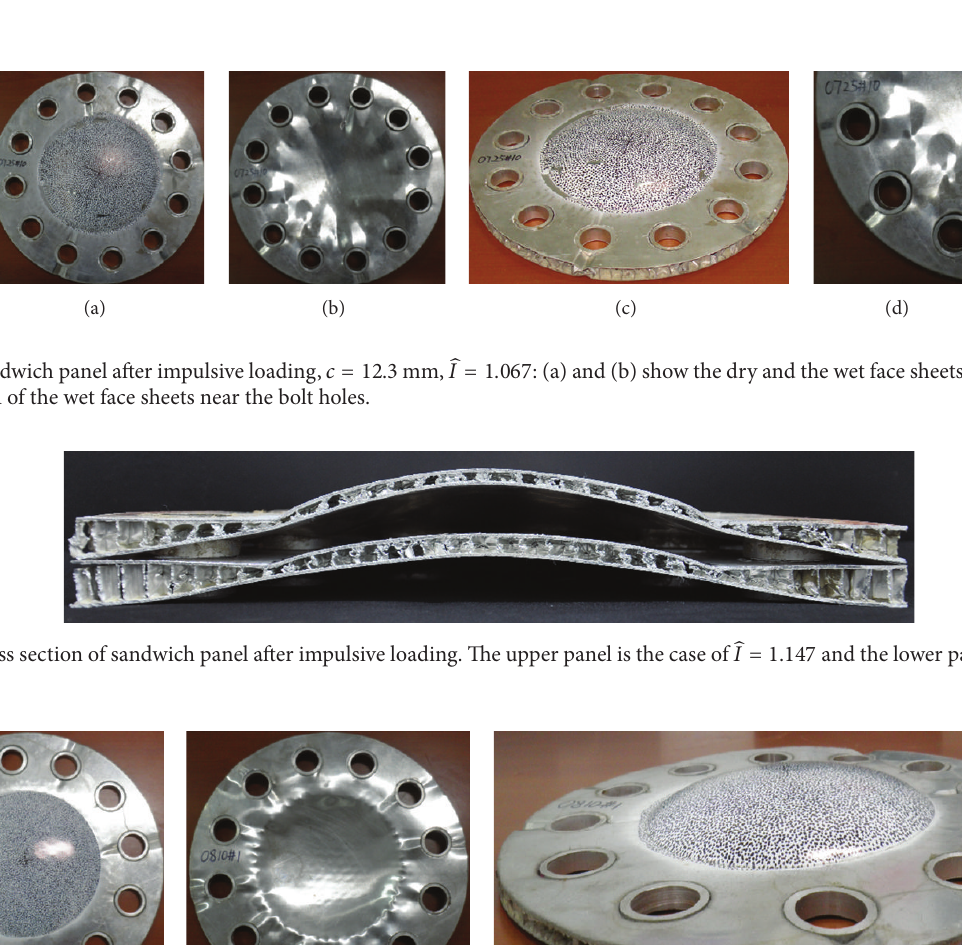
̂𝐼 = 0.630 : (a) and (b) show the dry and the wet face sheets; (c) shows a side